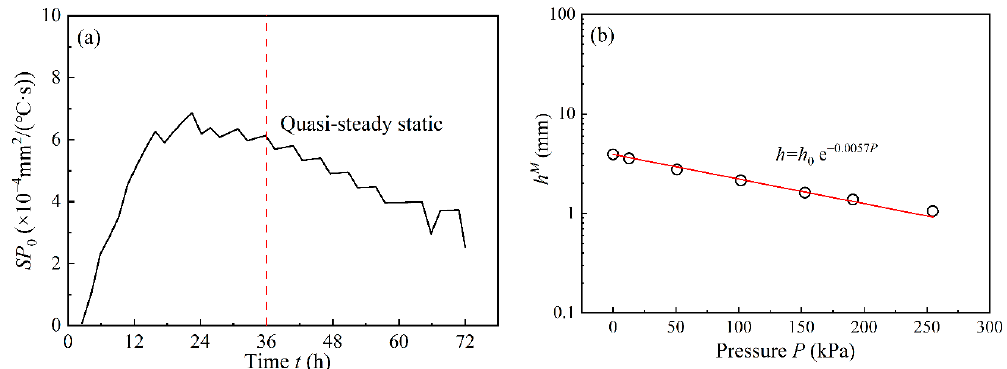
Figure 7. ( a ) Variation of segregation potential under no load with the freezing time, ( b ) variation of final frost heave with the external pressure.